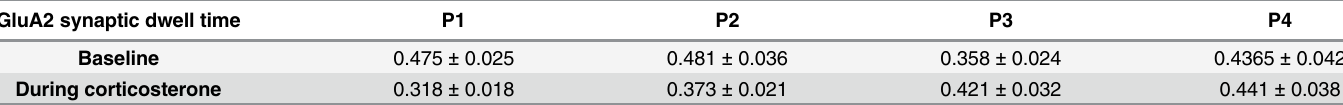
Table 3. Values of GluA2 AMPAR synaptic dwell-time: before (baseline) and during corticosterone exposure. The values are expressed in seconds and as (mean ± SEM). The synaptic dwell-time corresponds to the time (sec) spent by a diffusing GluA2-AMPAR within the synaptic area (see Methods for details). The values were obtained in live cultured hippocampal neurons of at least 10 days in vitro . GluA2 synaptic dwell